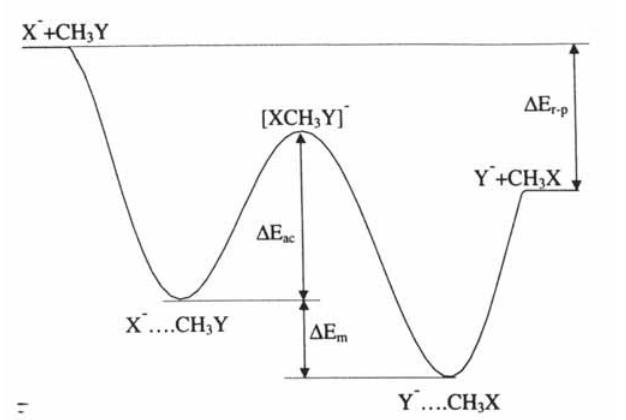
2 reaction in the gas phase (Reprinted with permission by the Figure 11. Reaction Profile for a S N American Chemical Society - Reference